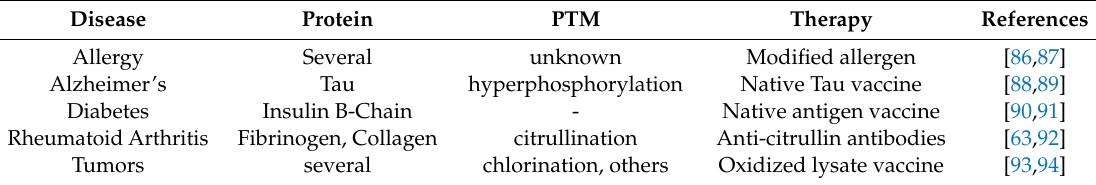
Table 2. Using or targeting protein PTMs to control the disease.